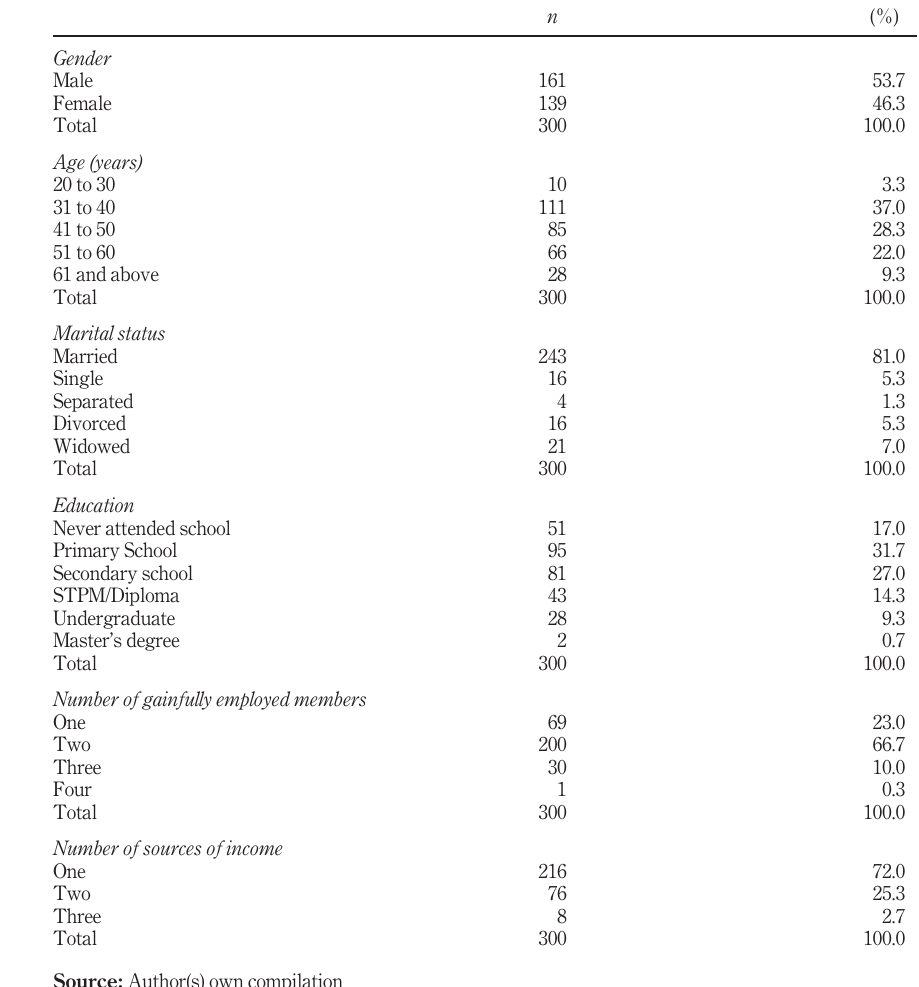
Table I. Pro fi le of the